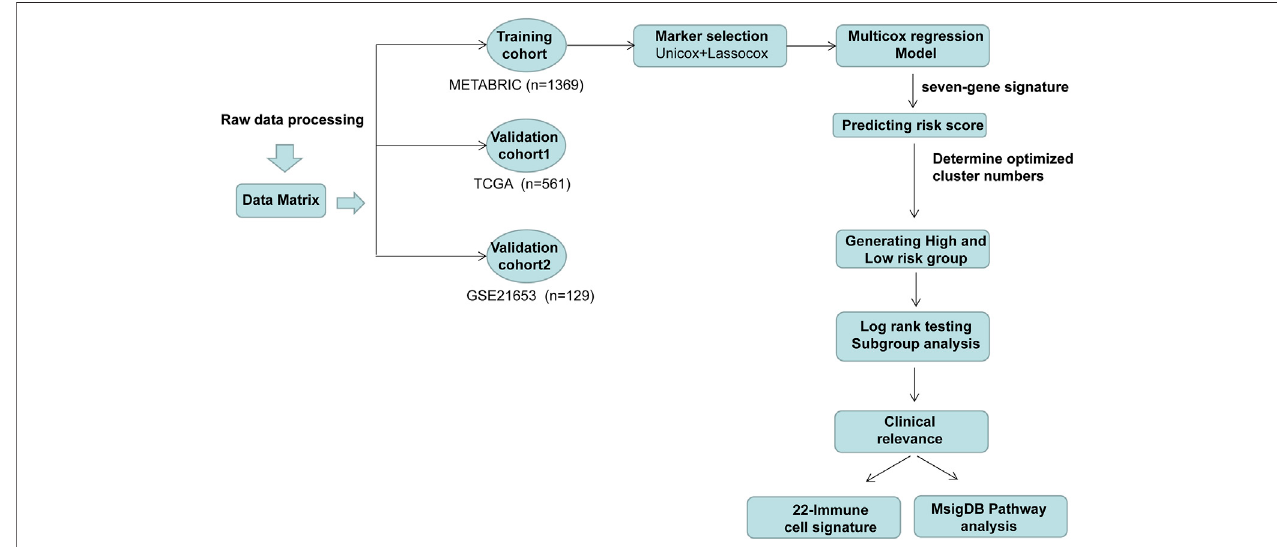
FIGURE 1 | Flow chart showing the selection of immune-related genes and analysis process.